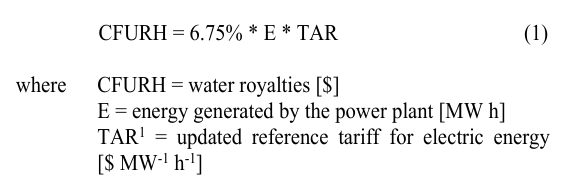
Figure 1. Location of the Furnas hydroelectric power plant